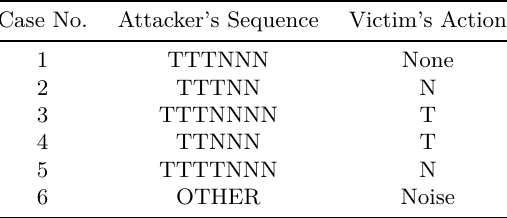
Table 5: The corresponding relationship between the attacker’s execution directions and the victim’s action. T – a taken branch, N – a not-taken branch Case